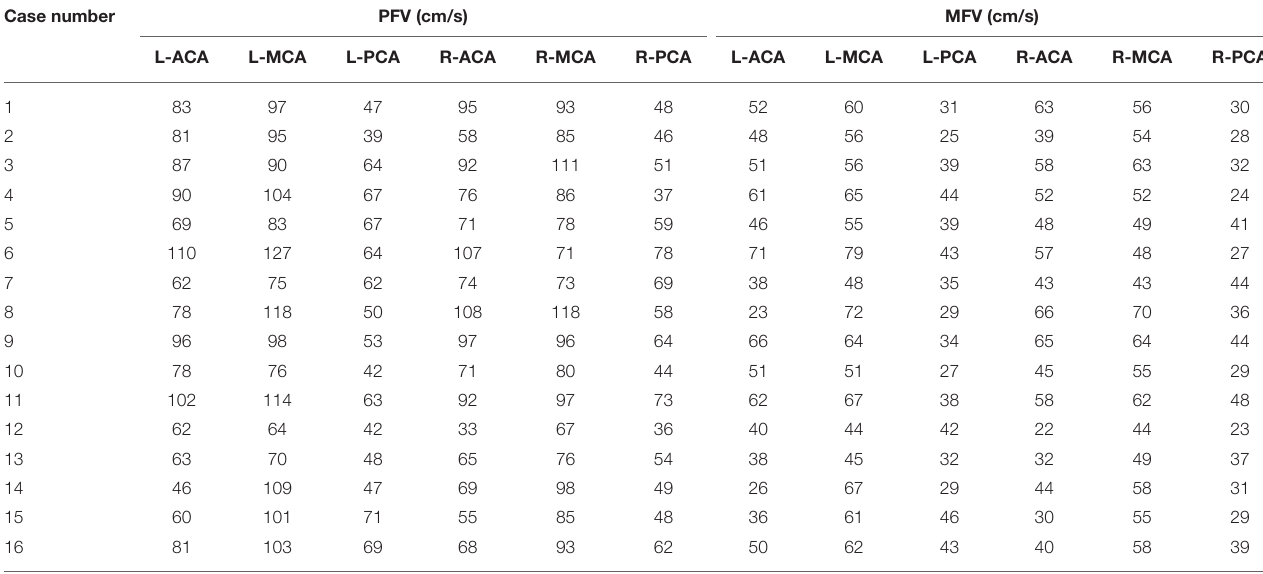
TABLE 3 | The peak flow velocity (PFV) and mean flow velocity (MFV) of the